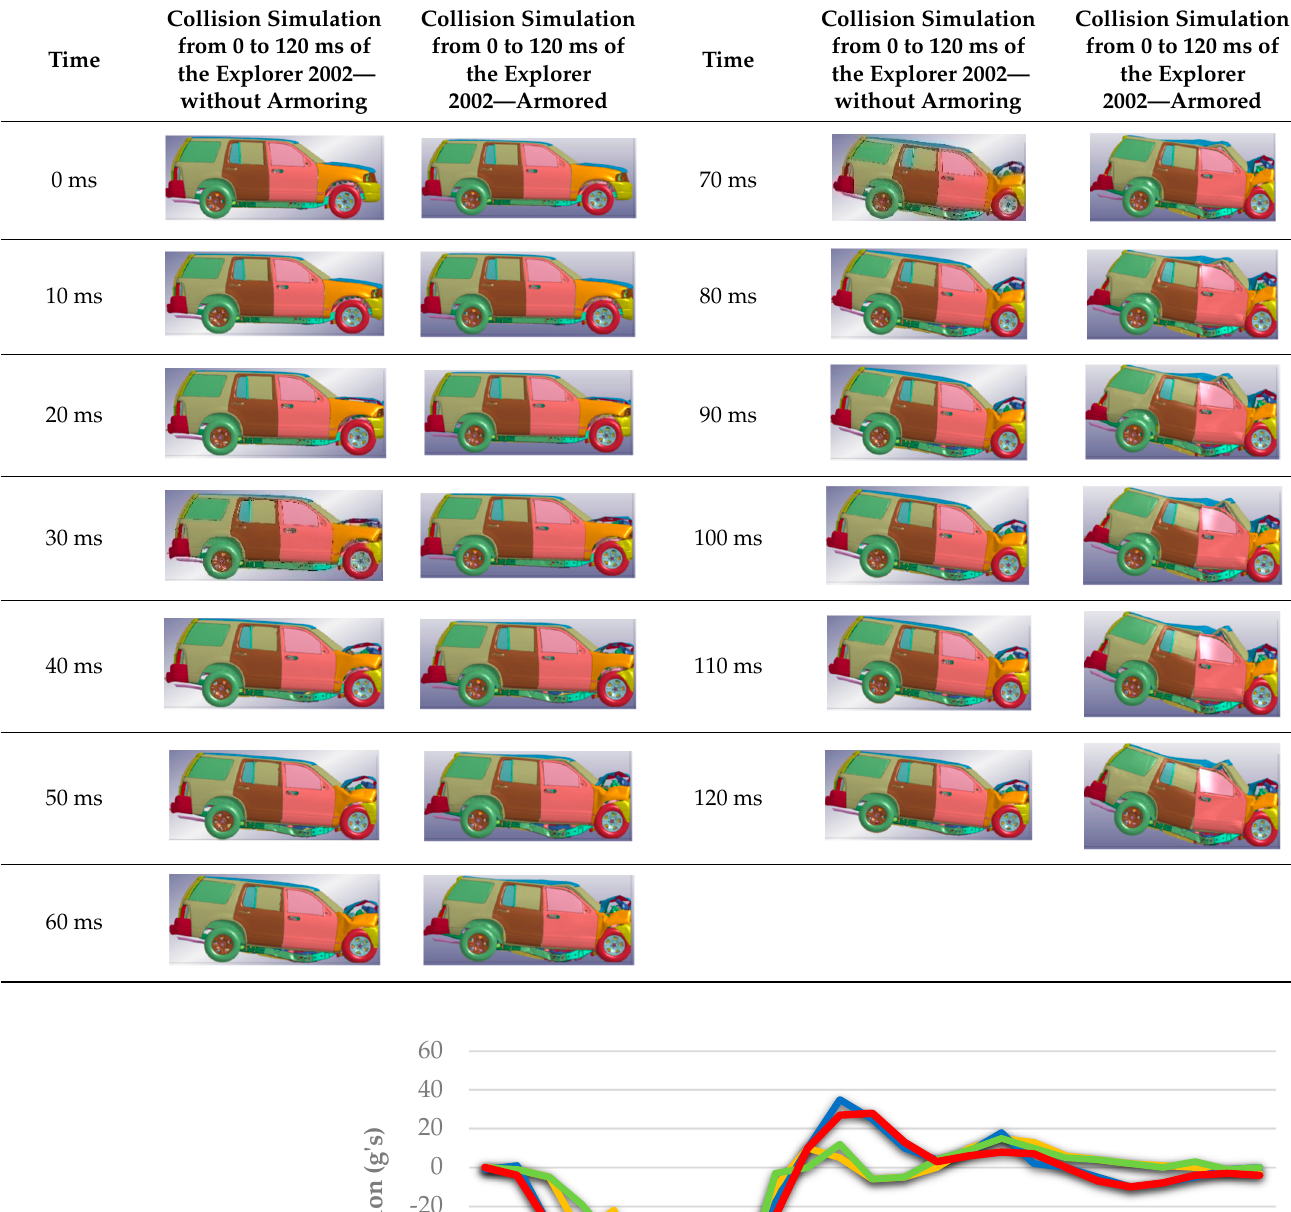
Table 4. Collision simulation of the armored SUV and unshielded SUV.